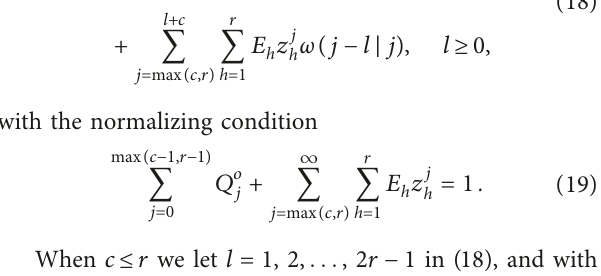
Figure 2: GI X / Geo / c with EAS at pre-arrival and random time